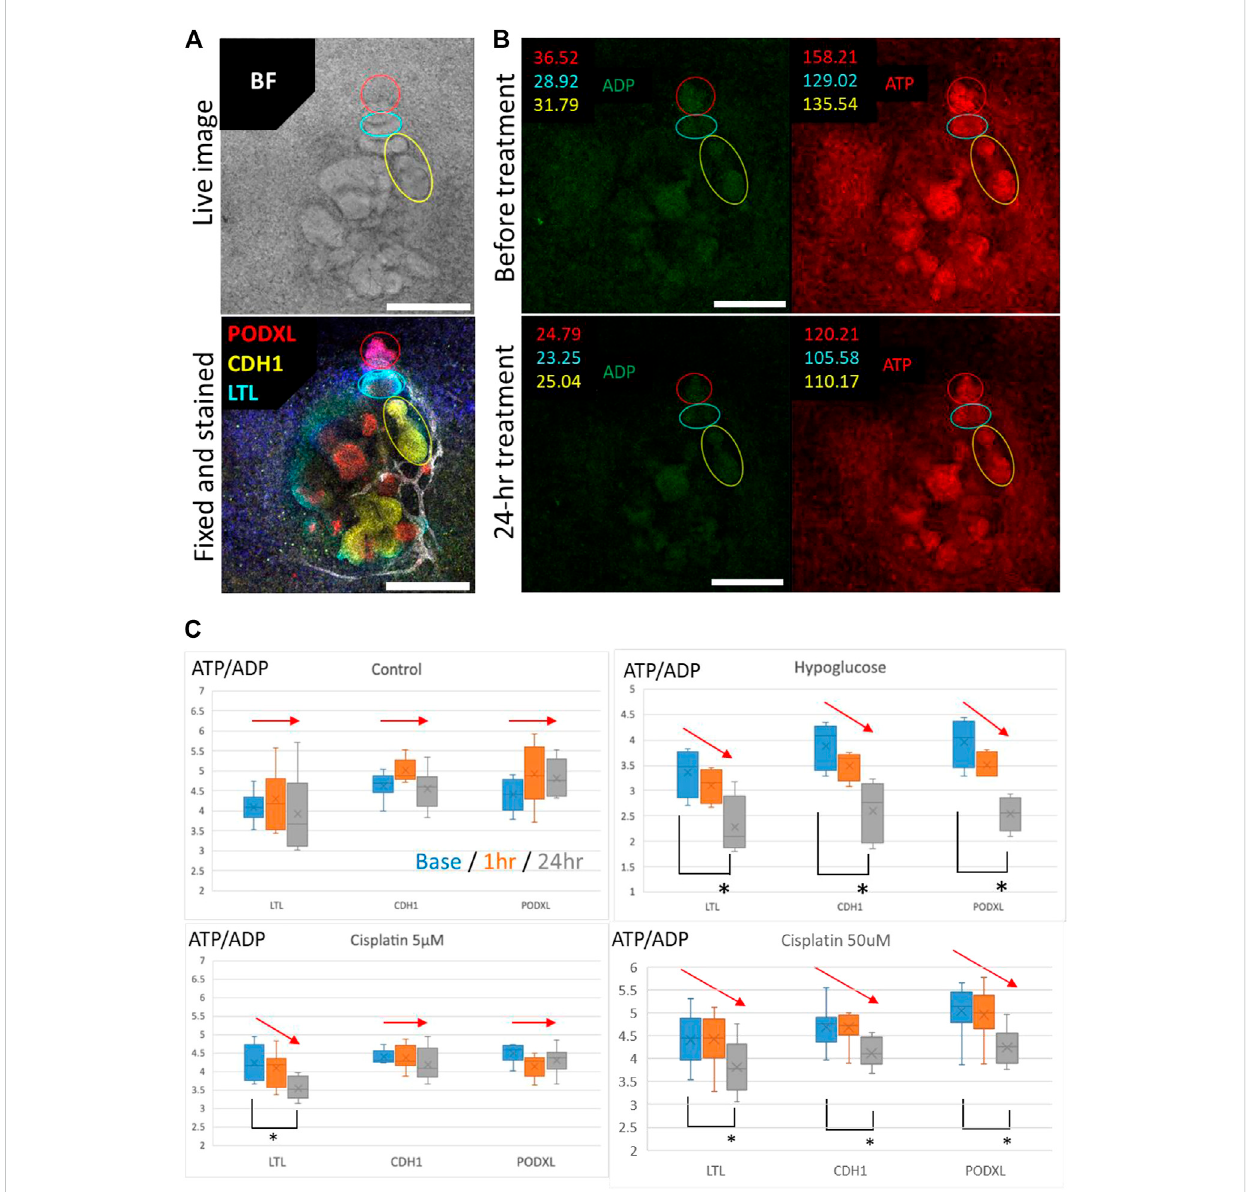
FIGURE 8 Evaluation ofthesegment-speci fi cinjury byPercevalHRorganoids. (A) RepresentativeBFimageandIFimageofPODXL(red),LTL(cyan),and CDH1 (yellow)in2Dorganoids.Scalebars:200 μ m. (B) Representativeimagesforquanti fi cationofATP/ADPratiomatchedinpositionwiththeBFandIFimages forsegment identi fi cationin2Dorganoidsexposedto 5 μ Mcisplatin.Scalebars:200 μ m. (C) Detection ofATP/ADPratioofeachsegment in2Dreporter organoids treated with hypoglucose, 5 and 50 μ M cisplatin for 24 h n = 4 to 15. * p <